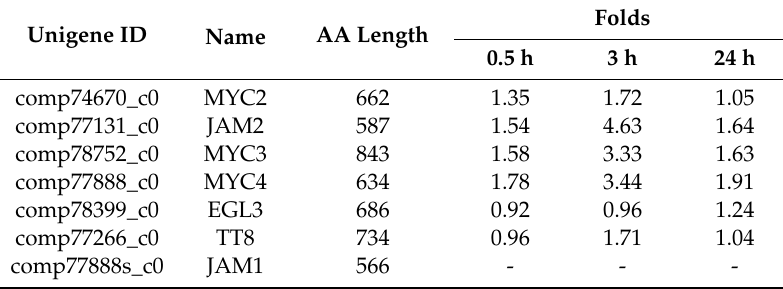
Table 3. List of MYC transcription factors in